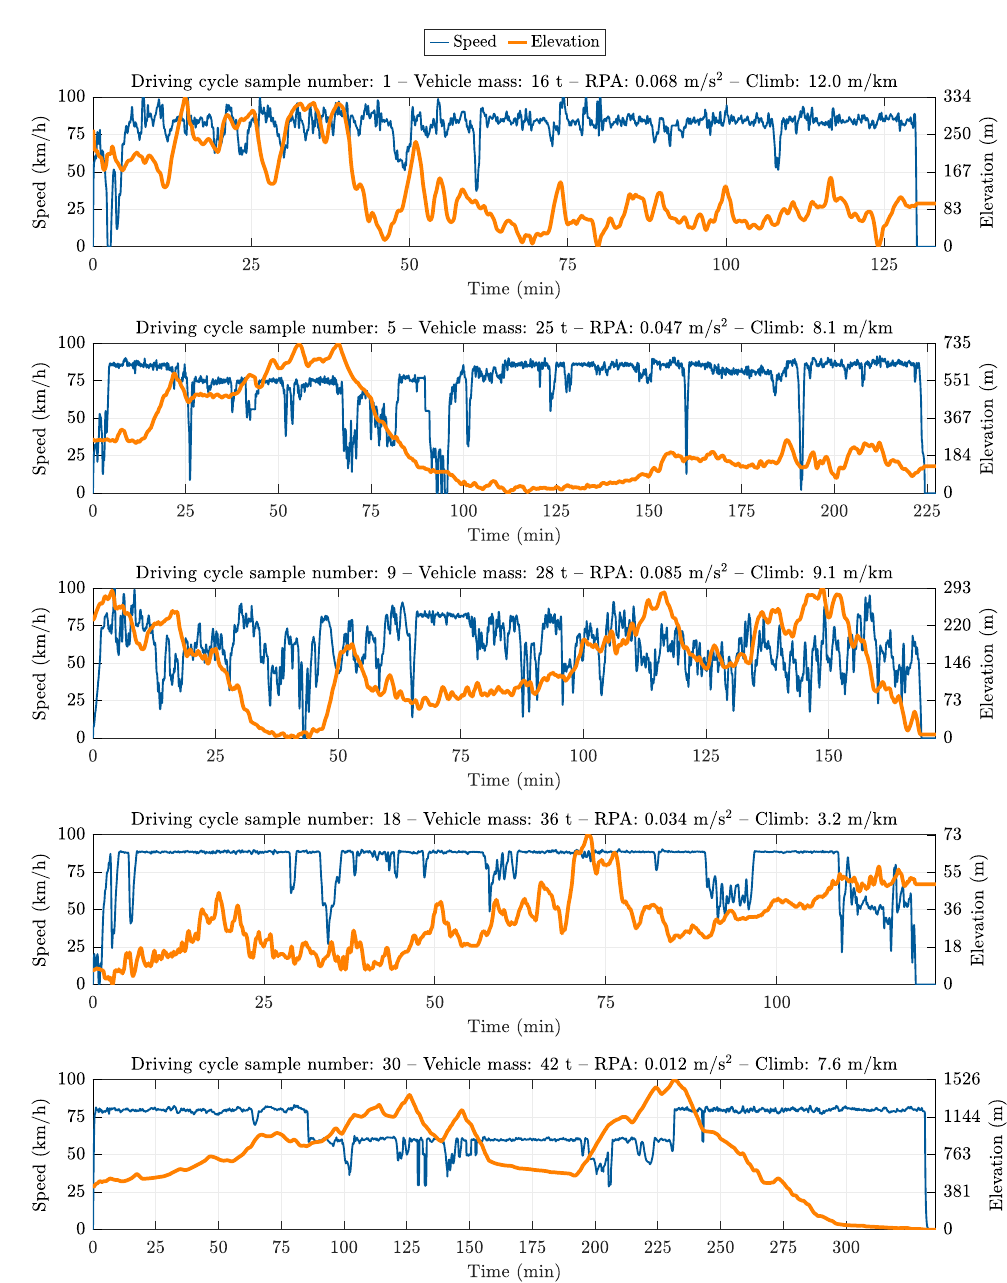
Figure 4. Speed and elevation profiles of five selected real-world driving